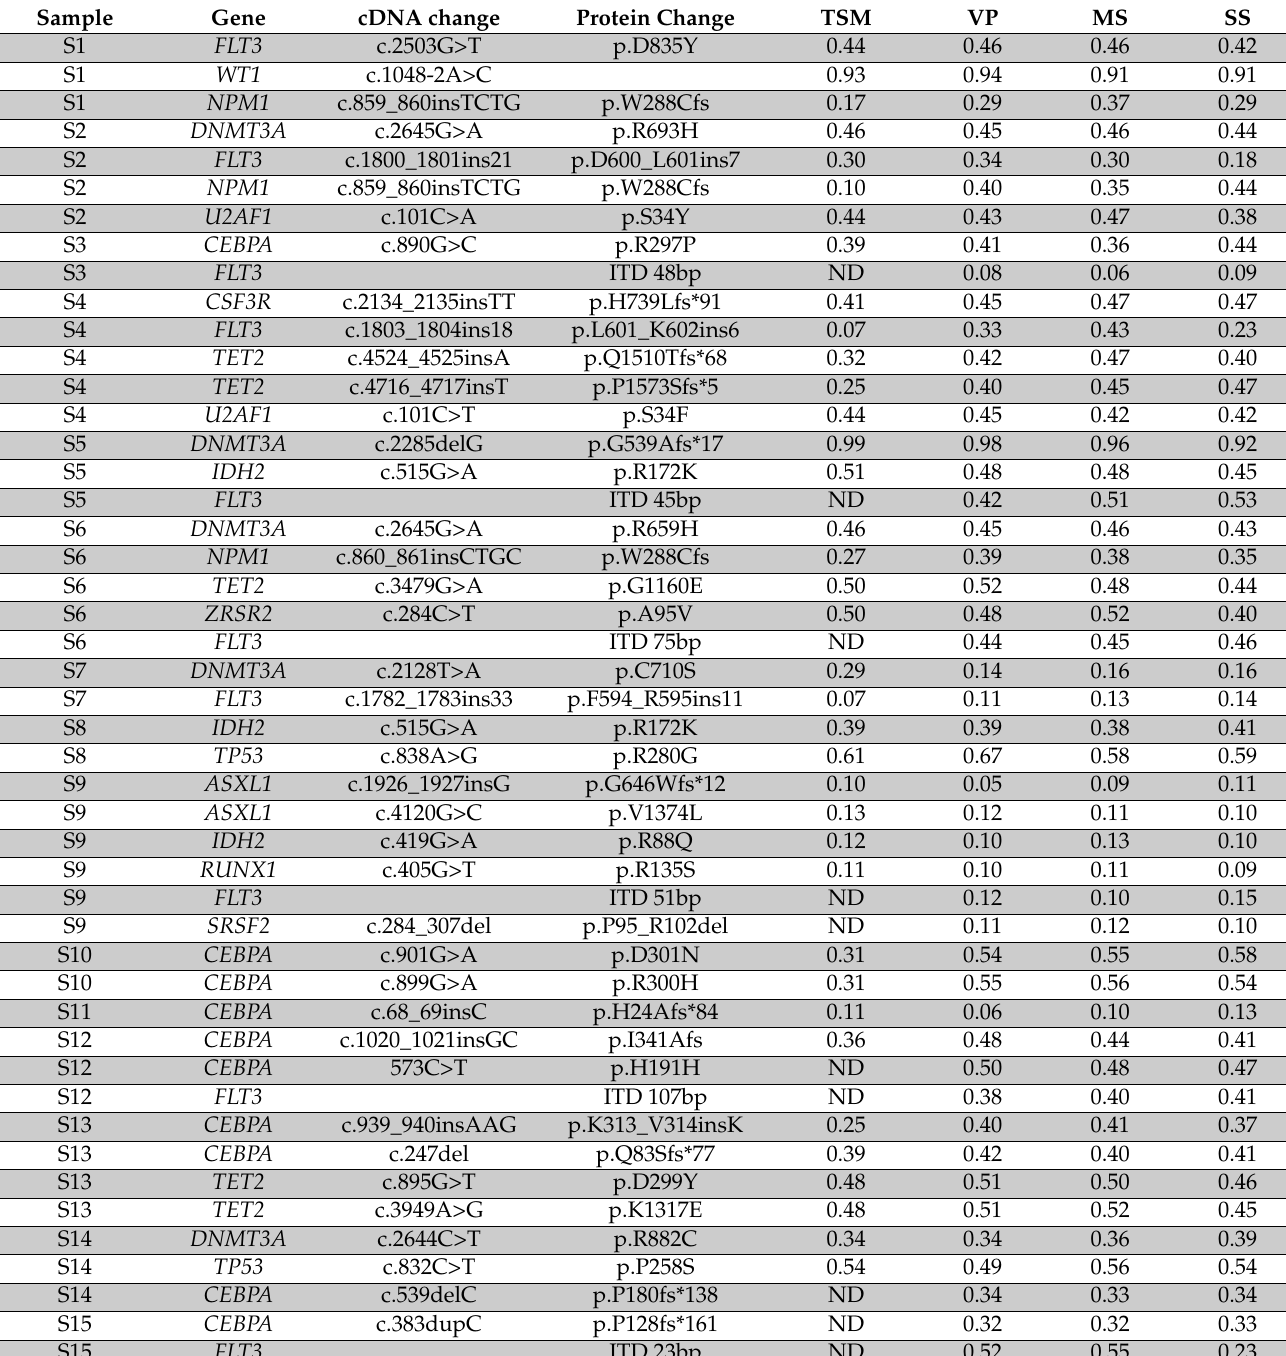
Table 4. Variants